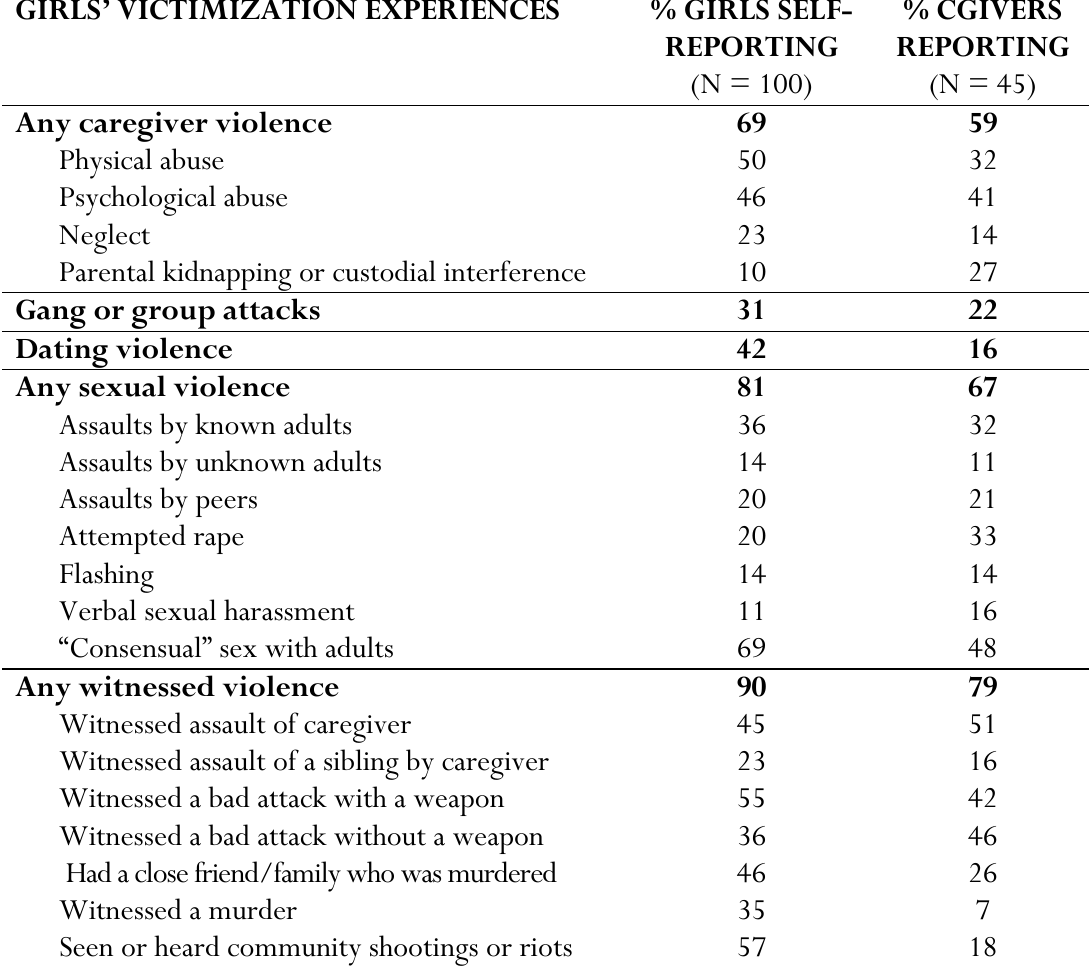
Table 1: Prevalence of Self-Reported & Caregiver-Reported Victimization for Girls GIRLS’ VICTIMIZATION